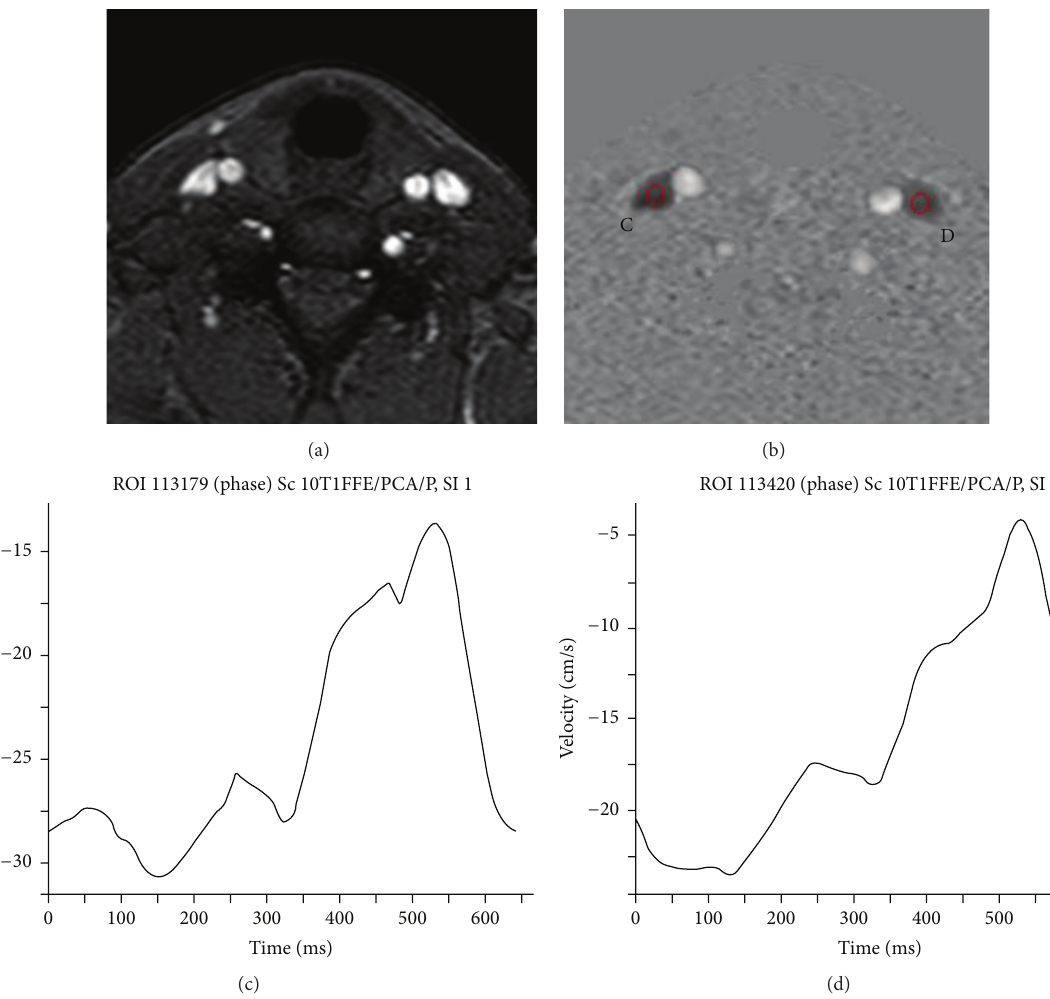
Figure 3: 2D Cine phase contrast at C5-C6 level: (a) magnitude image that displays carotids and IJVs; (b) phase image at the same level displaying dark flow directed to the heart and bright flow directed to the brain, with C and D indicating ROIs for flow measurements within IJVs bilaterally; and (c, d) velocity curves, respectively, for C and D